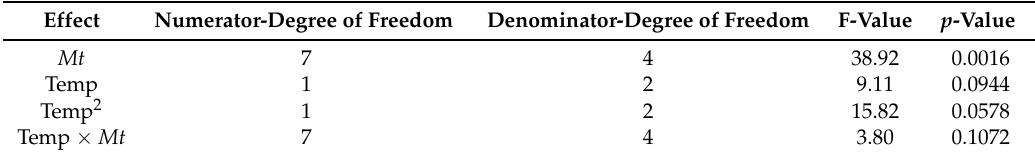
Table 5. Type III test of fixed effects of Model (5) related to NO 2